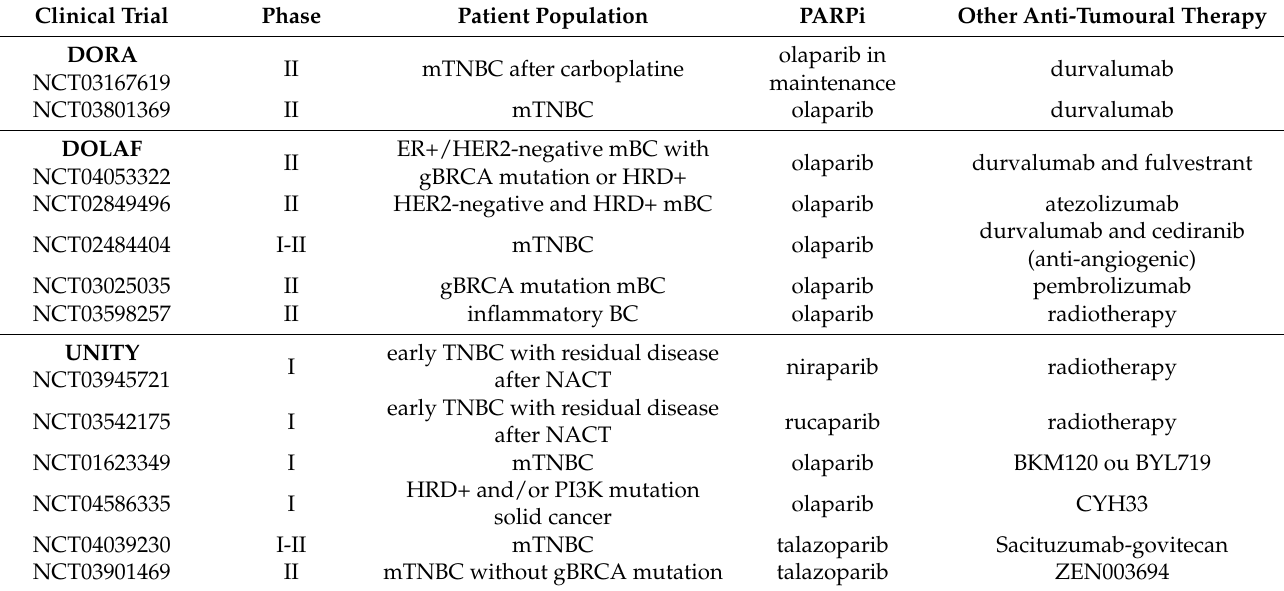
Table 1. Main ongoing trials in BC combining PARPi and other anti-tumour